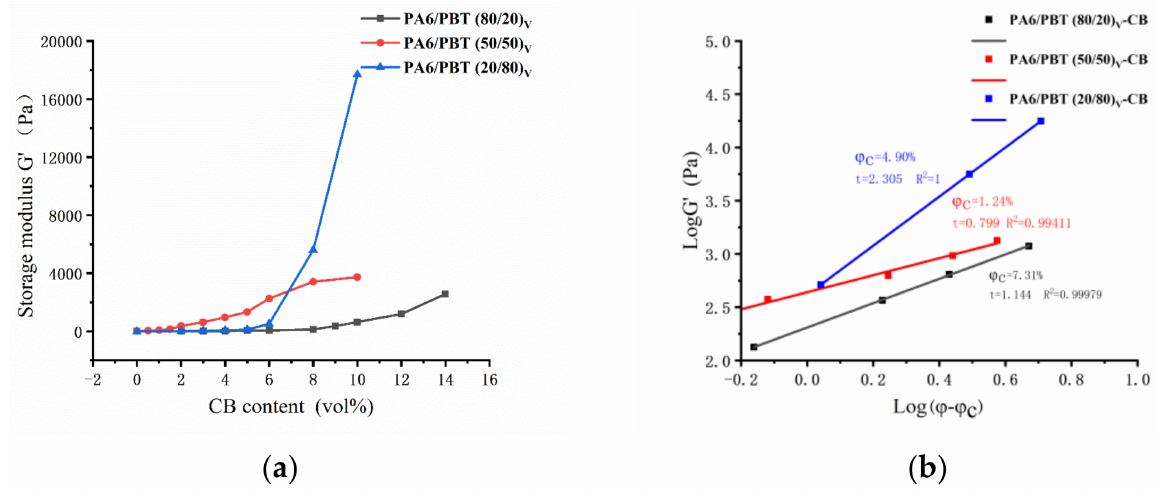
Figure 6. Storage modulus G’as a function of CB content ( a ), a log–log plot of storage modulus versus ( ϕ − ϕ c ) ( b